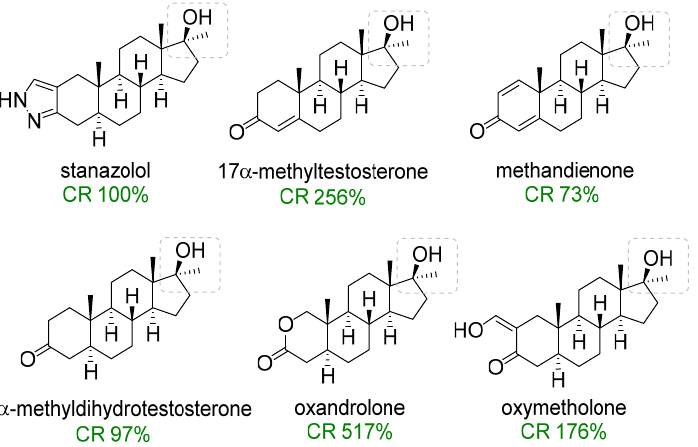
Figure 1. Molecular structures of major 17 α -methylated anabolic steroids and their cross-reactivities (CR) (CR data from Huml et al. [7]).